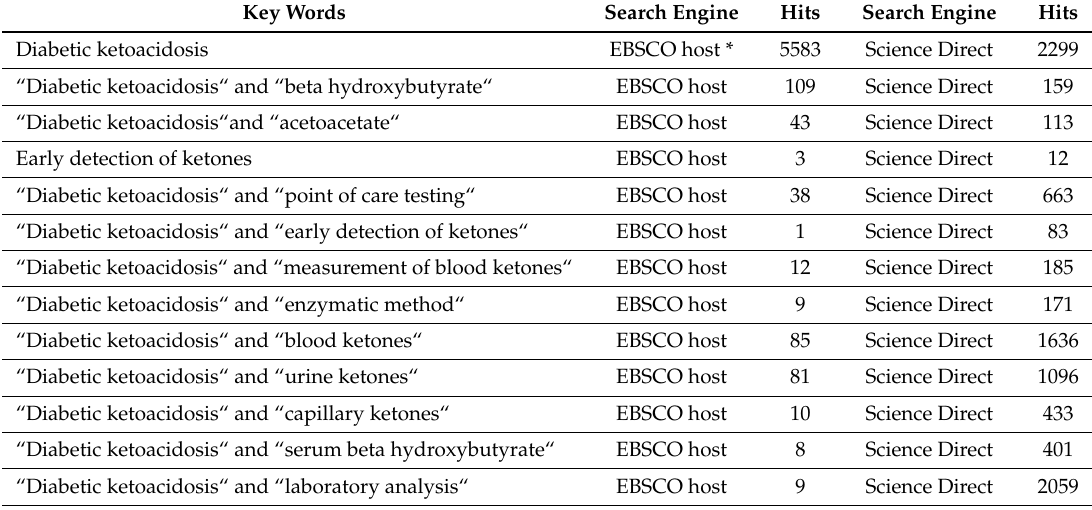
Table 1. Literature search